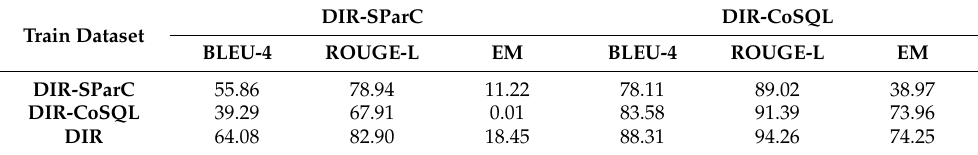
Table 6. Rewriting performance on RUN with different parts of DIR as the training set. Train